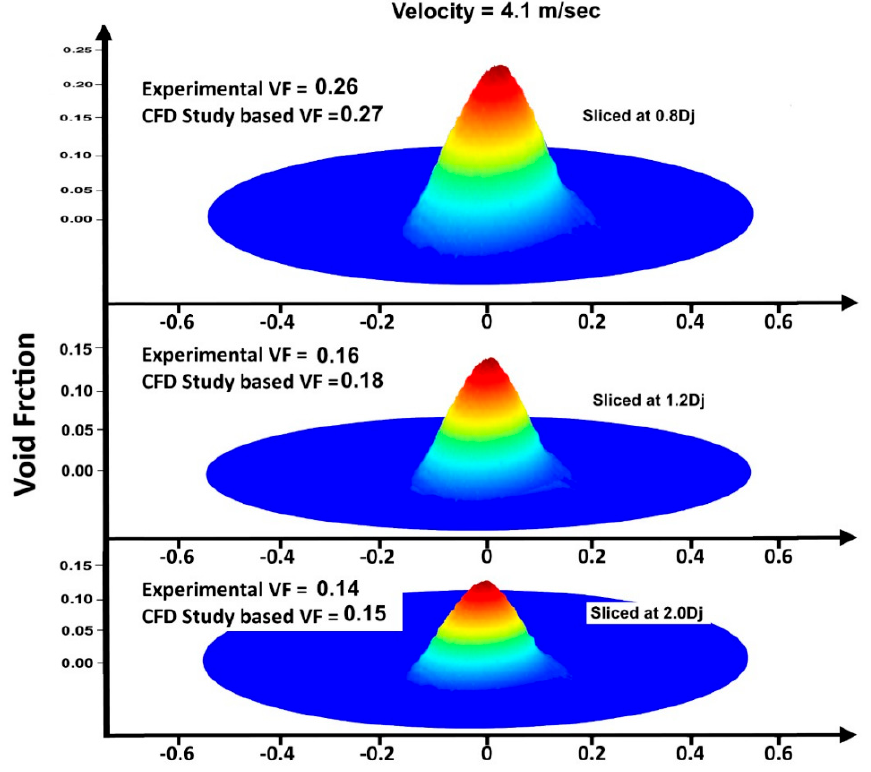
Figure 9. VOF Simulated Void Fraction Distribution at 0.8, 1.2 and 2.0 D j for Jet Velocity of 3.5 m/s.